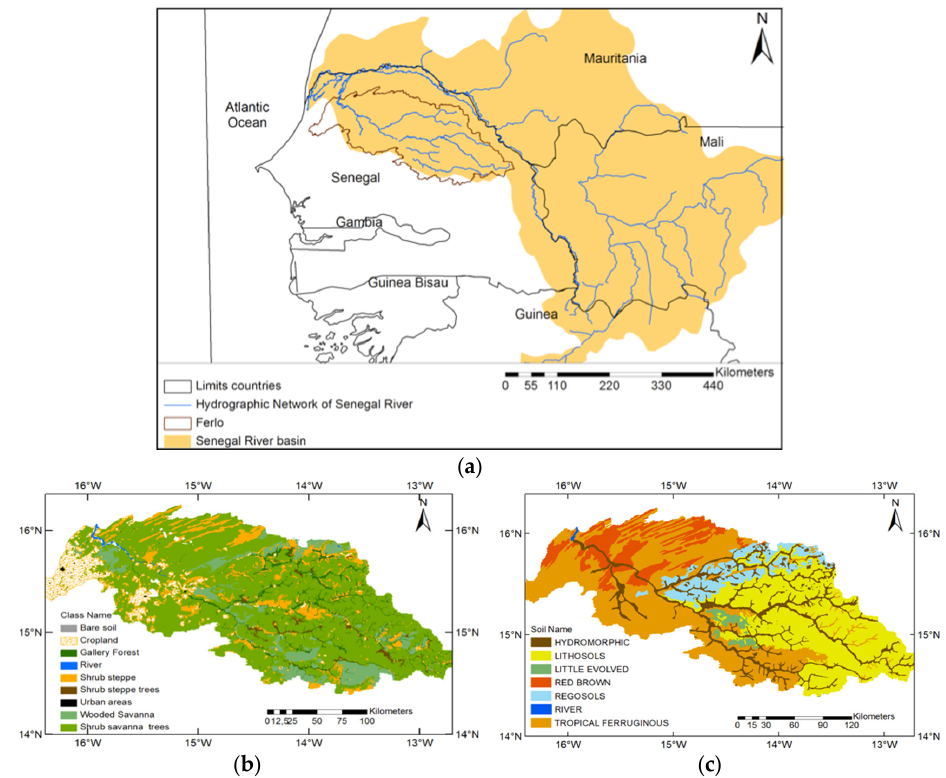
Figure 1. ( a ) Location of the Ferlo watershed study area; ( b ) land-cover map obtained from the FAO for 2005 [17] ( Centre de Suivi Écologique (CSE), Dakar ); ( c ) Soil type map extracted from the Senegalese Plan National d'Aménagement du Territoire (PNAT) published in 1986. Table 1. Description of the five main soil types in the Ferlo watershed derived from the Plan National d'Aménagement du Territoire (PNAT) map of Senegal soils in 1986 ( from Centre de Suivi Écologique (CSE), Dakar).